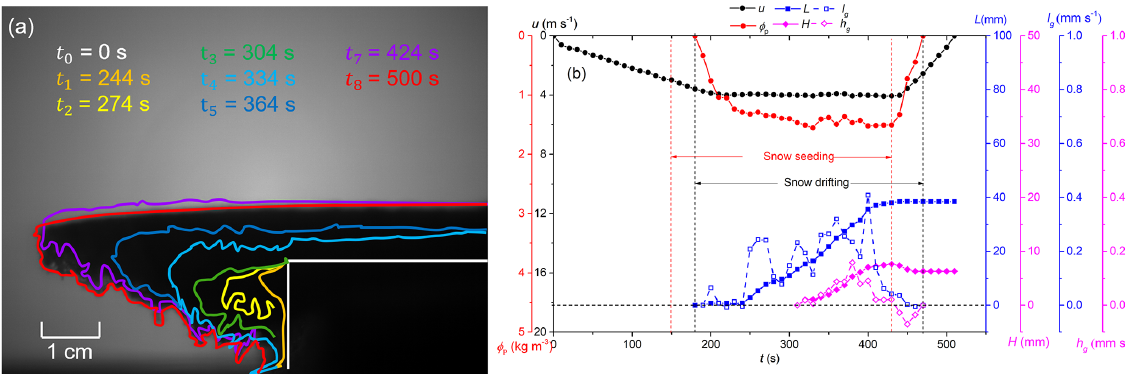
Figure 3. (a) Cornice profiles in the growth process. (b) Variation in cornice length (blue squares), thickness (pink diamonds), length growth rate (hollow blue squares), cornice thickness growth rate (hollow pink diamonds), wind speed (black circles), and particle mass concentration in the air (red circles).